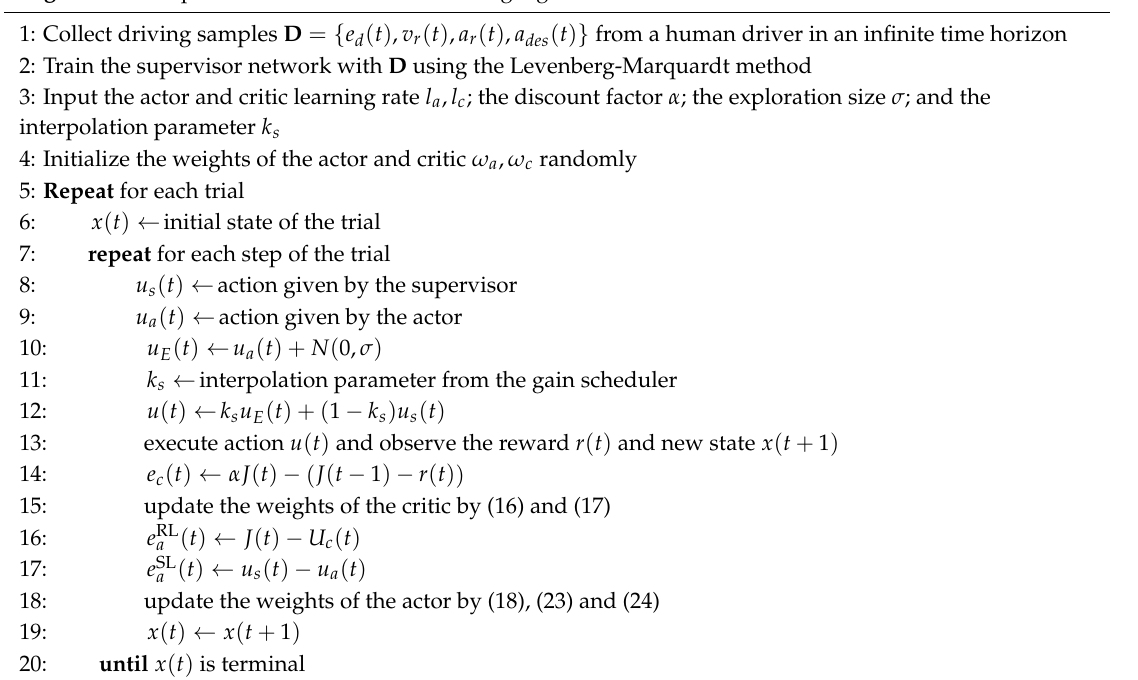
Algorithm 1. Supervised Reinforcement Learning